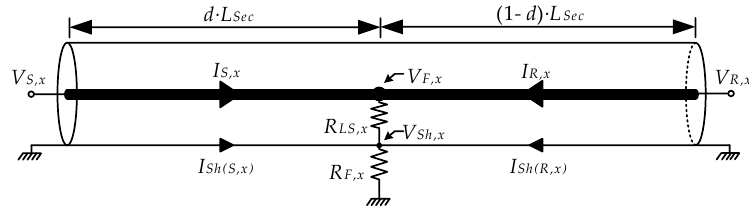
Figure 8. Line section model for the Personal et al. [57]